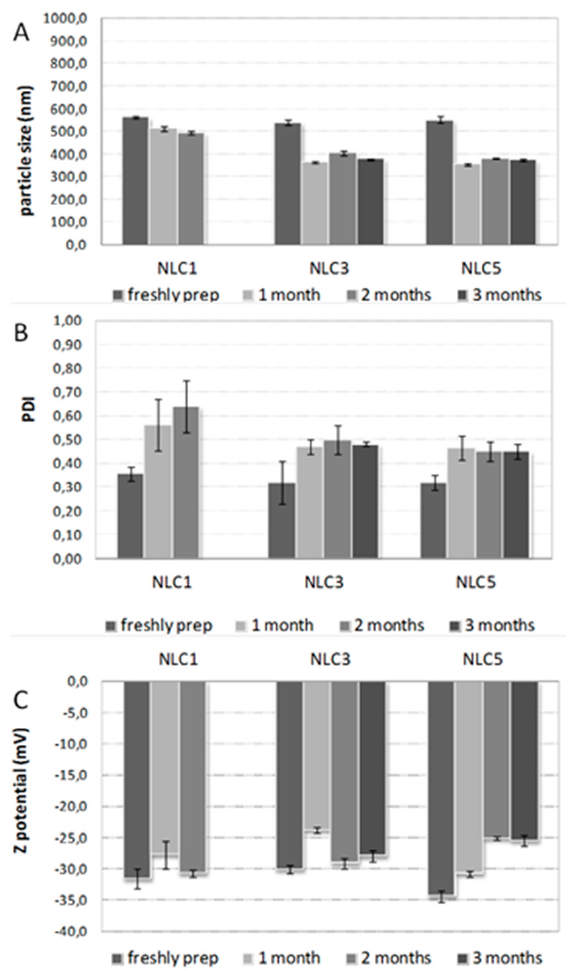
Figure 5. Stability studies of Tween ® 80-based NLC containing the drug as such (NLC1) or as P.M. (NLC3) or GR system with HP β CD (NLC5), freshly prepared and after 1, 2 and 3 months storage at 4 ◦ C in terms of mean size ( A ), polydispersity index, PDI ( B ) and Zeta potential ( C